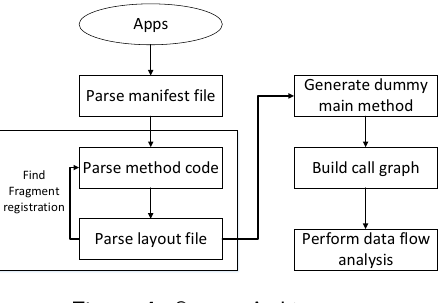
Figure 4. System Architecture